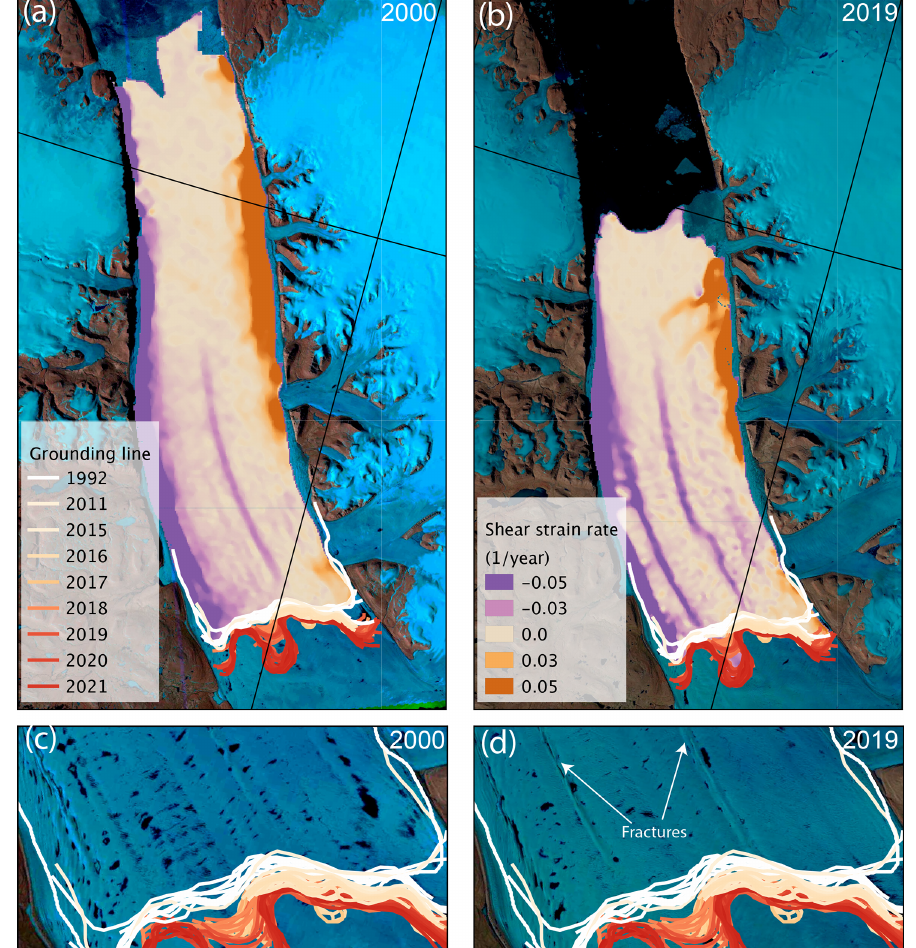
Figure 4. Shear strain rates of Petermann Glacier in 2000 (a) and 2019 (b) , overlaid on Landsat images from the same year. Strain rates are color coded from violent to orange. Panels (c) and (d) display the surface expression of the shear strain maps from Landsat-7 and Landsat-8 images taken in 2000 and 2019, respectively. Solid color lines show the grounding line position between 1992 and 2021, color coded on a scale from white (1992) to red